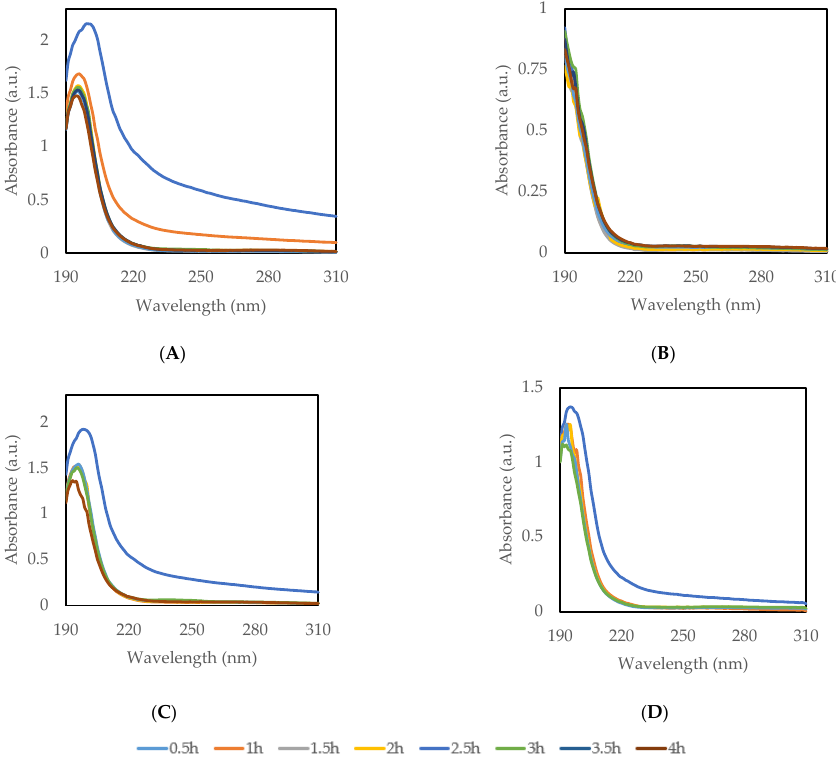
Figure A6. The UV-Vis spectra of samples during solubilization (no incubation). ( A ); chitin powder, ( B ); chitosan powder, ( C ); chitin nanocrystals (ChNC), ( D ); deacetylated chitin nanocrystals (D-ChNC).